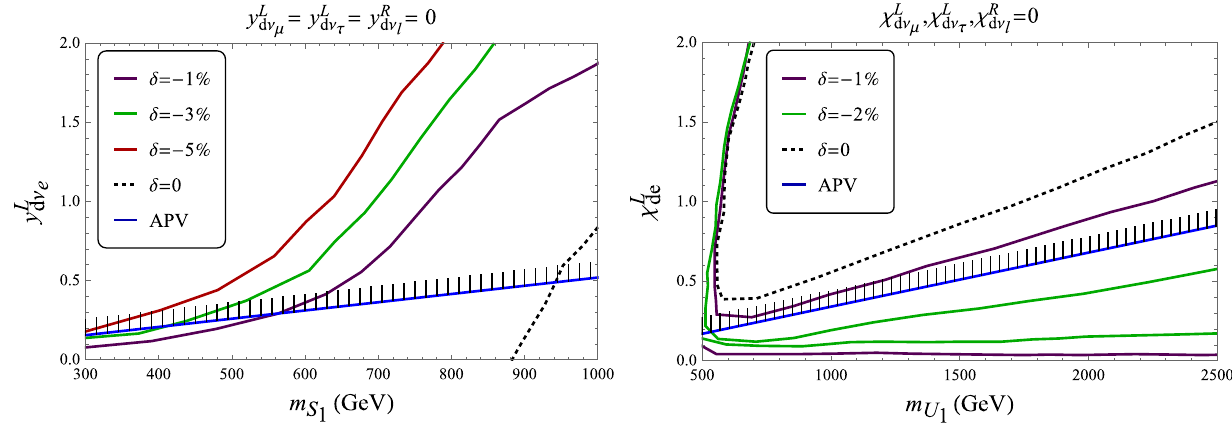
(χ L ) plane - y L in case of U 1 results in a fit comparable or better than the SM one. The d ν e de 1 ( U 1 ) region above the blue line is excluded at the 2 σ level by the limits from the APV